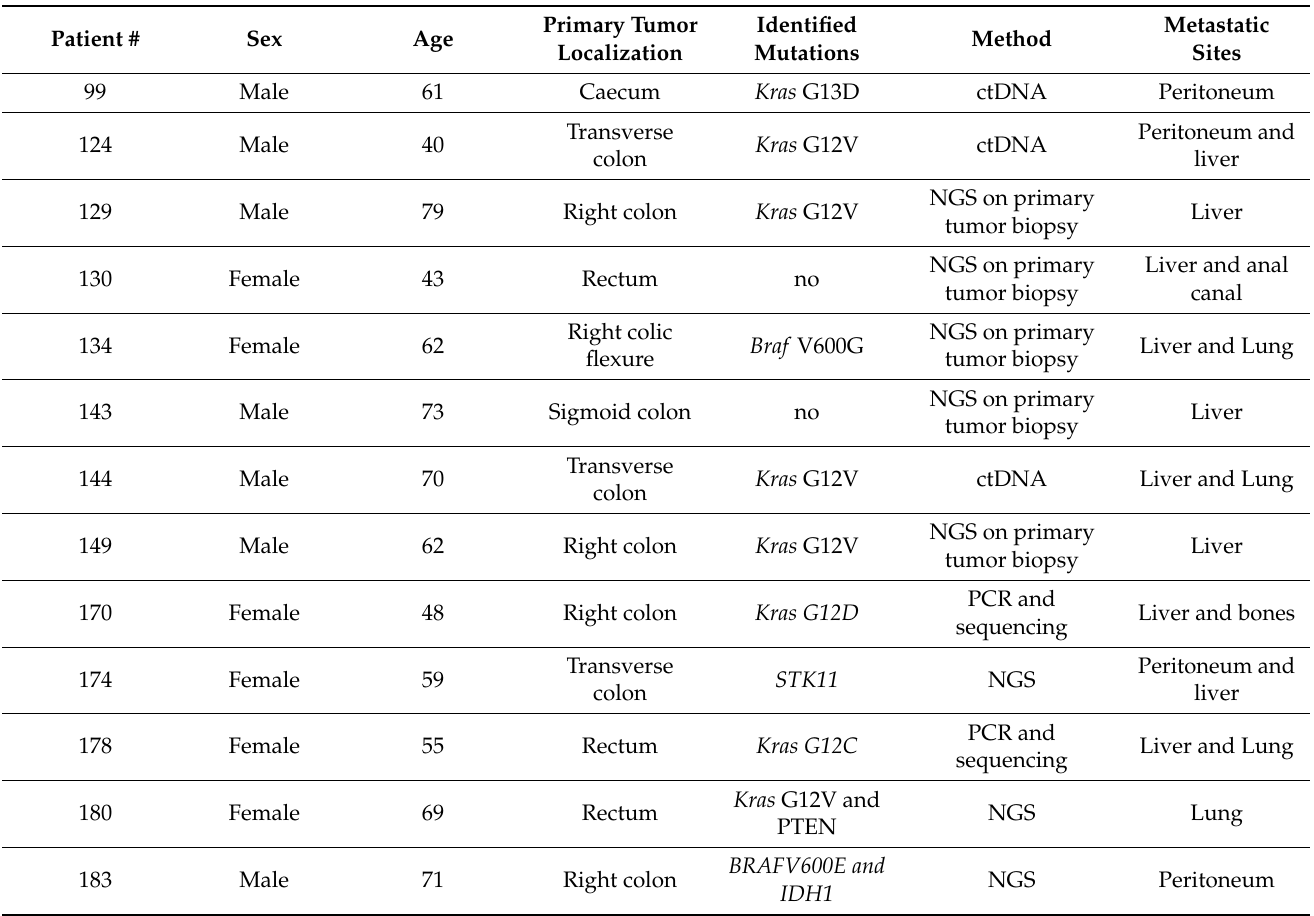
Table 1. Patient Clinical